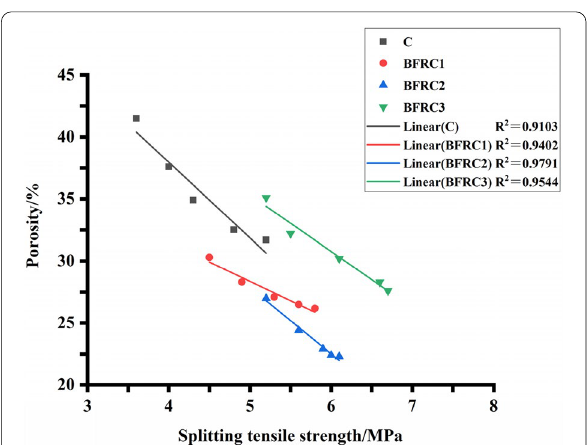
Fig. 18 Relationship between porosity and splitting tensile strength.